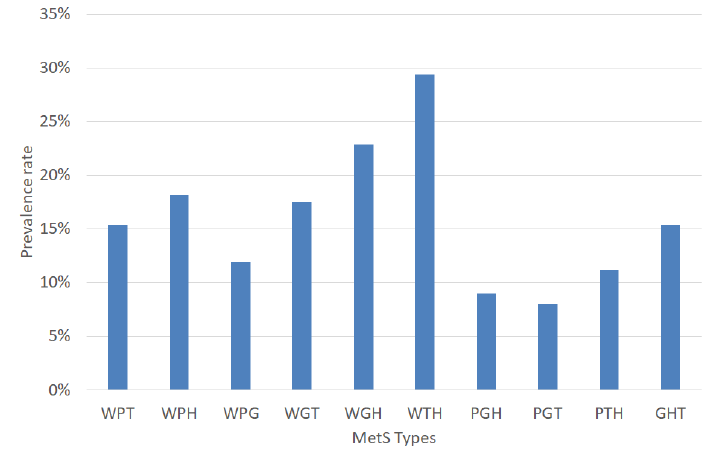
Figure 10. Prevalence rate of the MetS types using the dataset with